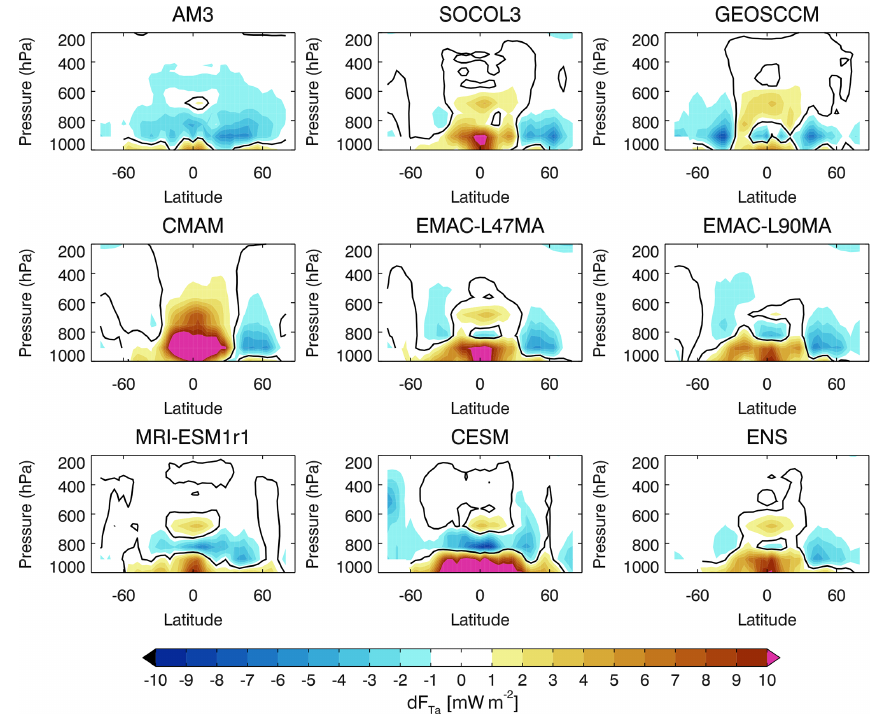
Figure 7. Vertical resolved T a radiative bias. The black curves are the zero lines.